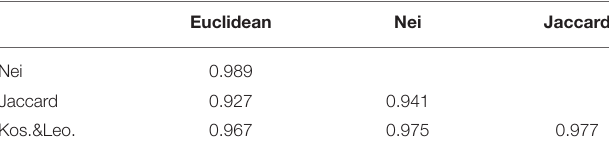
TABLE 1 | Correlation between different genetic distance matrices. Euclidean Nei Jaccard Nei 0.989 Jaccard 0.927